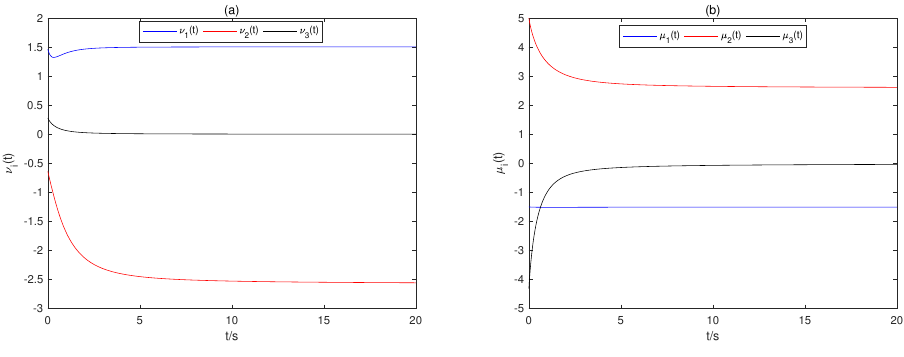
Figure 4. ( a ) Time responses of ν p ( t ) ; ( b ) µ p ( t ) , p =